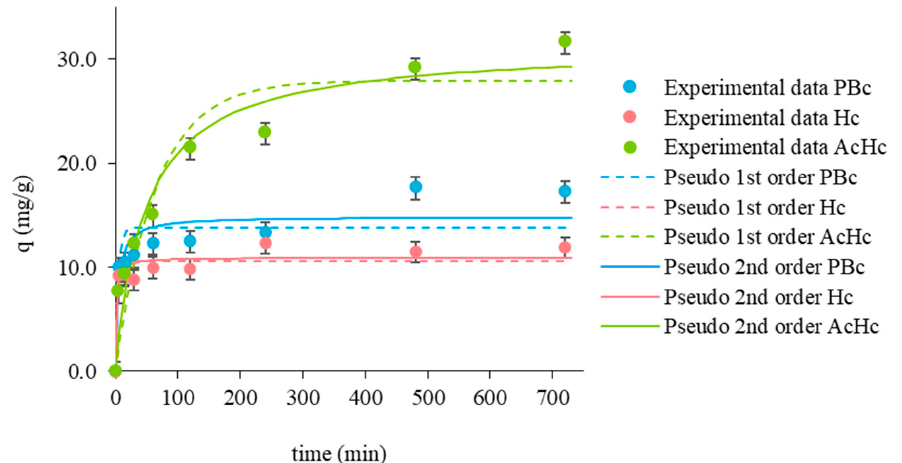
Figure 11. Kinetics for Pb (II) biosorption on PBc, Hc, and AcHc (values ± global uncertainty) at C 0 = 20 mg/L Pb(II), C s = 0.5 g/L biochar dosage, T = 23 ± 1 °C: experimental data and pseudo-first (1st) and pseudo-second (2nd) order model.